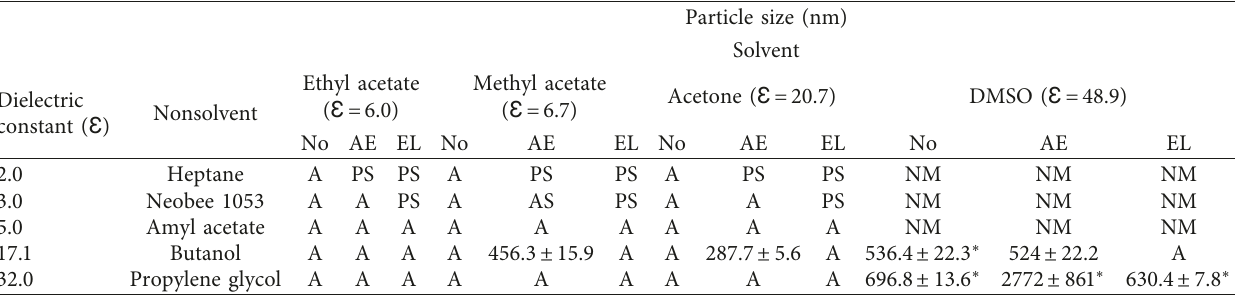
Figure 2: Strategies to increase the entrapped NAC in nanoparticles of PLGA. Table 1: Solvent and nonsolvent effect on nanoparticle formation by nanoprecipitation